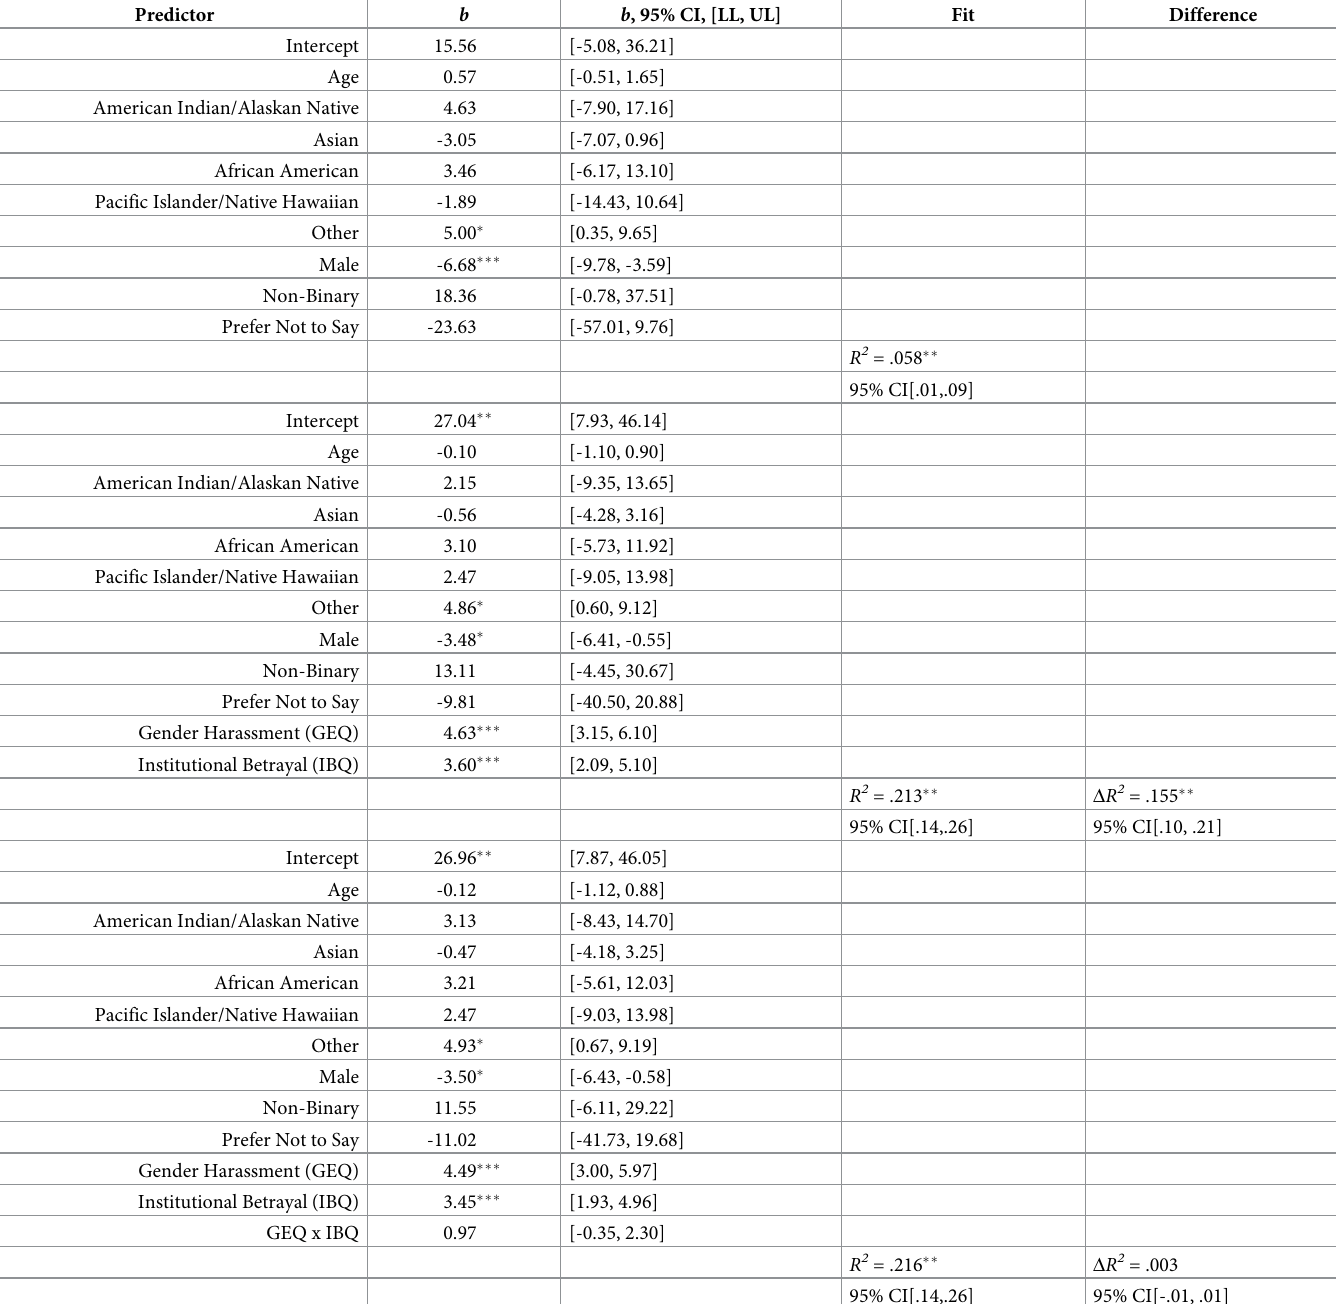
Table 3. Current trauma symptoms predicted by age, gender, race/ethnicity, gender harassment, institutional betrayal, and gender harassment x institutional betrayal (N = 535).